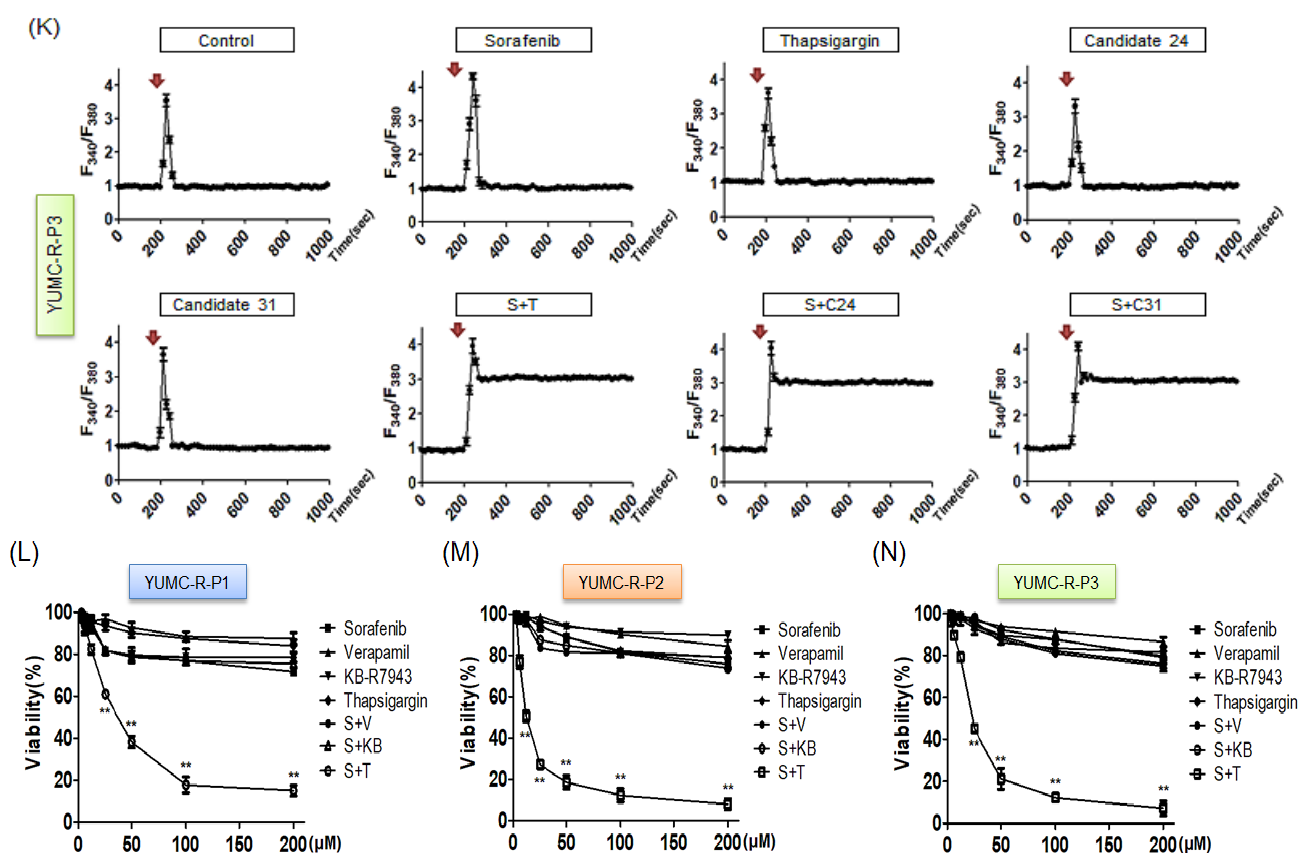
Figure 2. Plot of the study plan and in silico screening using the ECBS method to determine novel SERCA inhibitors. ( A ) The schematic diagram for determining novel SERCA inhibitors using the ECBS method. ( B ) Information and chemical structures of the novel SERCA inhibitors, candidates 24 and 31. ( C – F ) Combinational anti-cancer e ff ectiveness of sorafenib and novel SERCA inhibitors on sorafenib-sensitive and -resistant PTC cells. Cell viability of sorafenib-sensitive (( C ), YUMC-S-P1) and sorafenib-resistant (( D ); YUMC-R-P1, ( E ); -R-P2, ( F );-R-P3) PTC cells treated with sorafenib alone or combined with SERCA inhibitors. Points express the mean percentage of the values shown in the solvent-treated control. All experiments were repeated at least thrice. Data represent the mean ± standard deviation. * p < 0.05 and ** p < 0.01 versus control. *; C24 and *; C31. ( G ) IC 50 values for combinational treatment with SERCA inhibitors and sorafenib in soraf- enib-sensitive and -resistant PTC cells. Each datum shows the mean of triplicate. SEM, standard error of the mean; MTT, 3-(4,5-dimethylthiazol-2-yl)-2,5-diphenyltetrazolium bromide; IC 50 , half-maximal inhibitory concentration. The asterisk describes the lowest half-maximal inhibitory concentration. ( H – K ) Cytosolic-free calcium was measured after treatment with sorafenib, thapsigargin (SERCA inhibitor, positive control), and novel candidates (24 and 31) in soraf- enib-sensitive PTC and -resistant PTC. An arrow indicates the addition of high K + depolarization to increase growth in Ca 2+ on traces. ( L – N ) Cell viability assay of treatment with calcium channel blocker (verapamil), Na + /Ca 2+ exchanger (NCX) inhibitor (KB - R7943), and SERCA inhibitor (thapsigargin) alone or combined with sorafenib. * p < 0.05 and ** p < 0.01 versus control. We measured the variation of intracellular Ca 2+ levels with microspectro fl uorimetry.